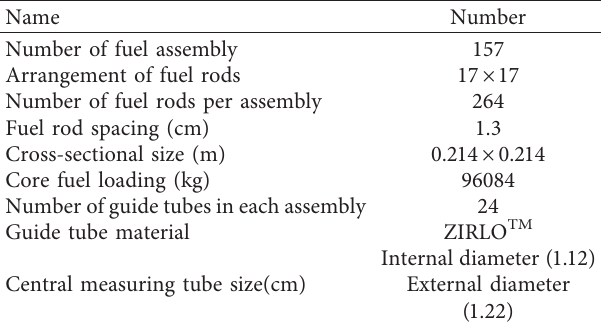
Table 1: Basic parameters of AP1000 fuel